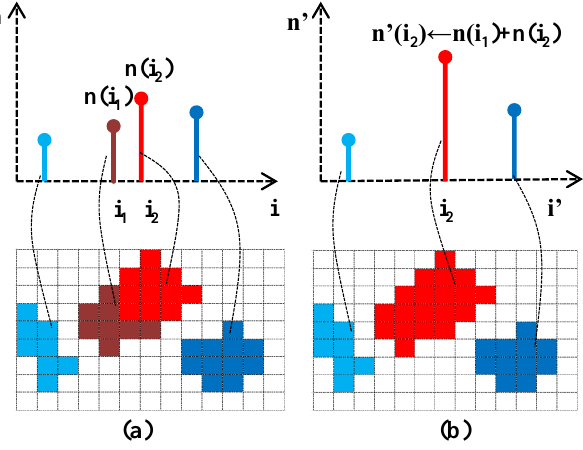
Figure 8. The histogram combining operations of an HDR image. ( a ) An illustration of the bin merge of a histogram. ( b ) The resulting histogram after bin merge.